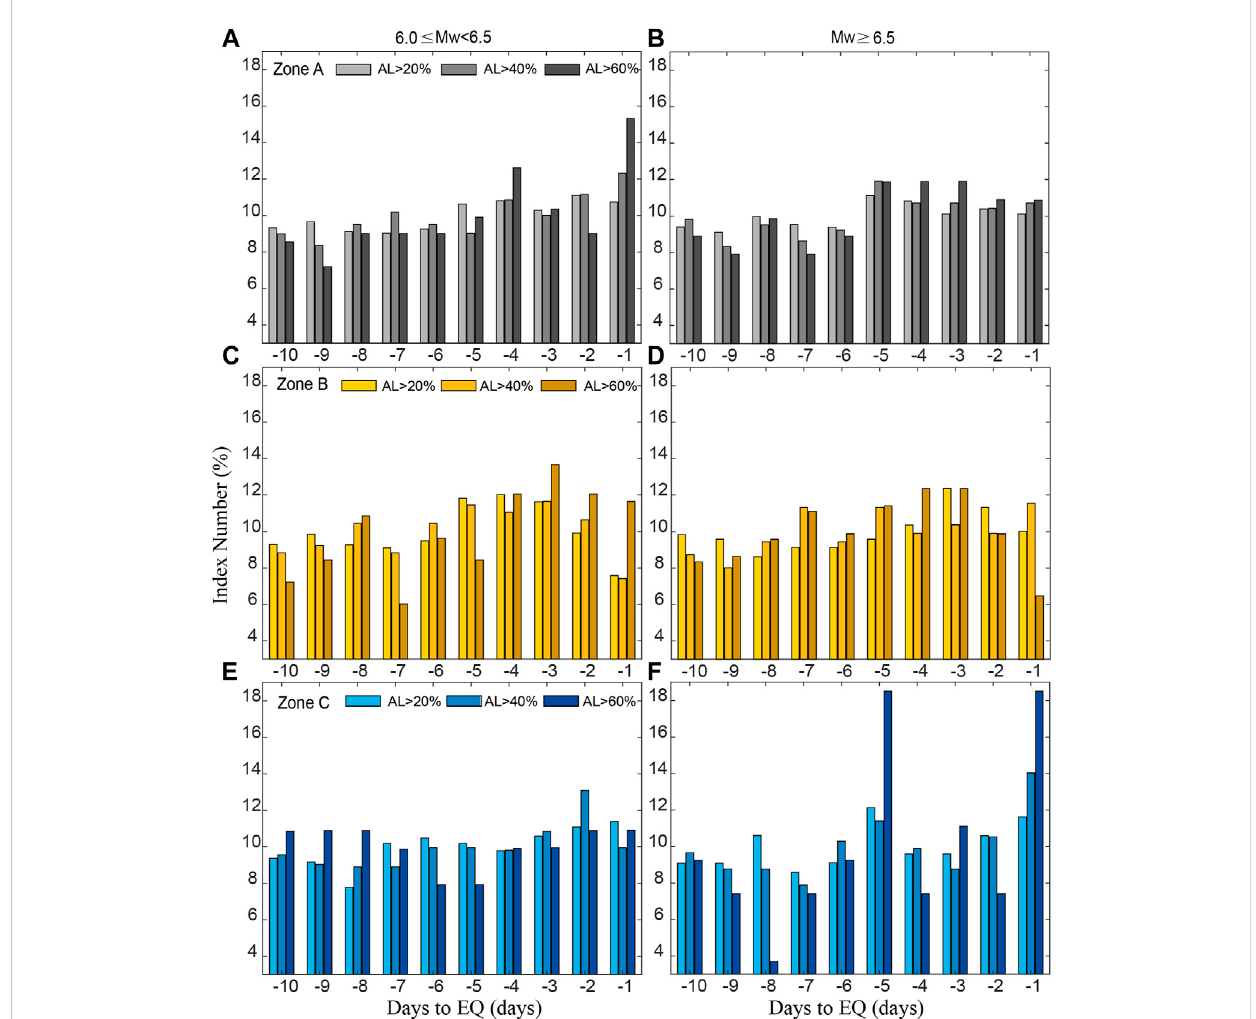
FIGURE 4 The Index Numbers of the seismo-ionospheric anomalies within 1-10 days before the global earthquakes during 2000-2020 (15-day sliding window). (A,C,E) aretheresultsof6.0 ≤ Mw < 6.5inZoneA,ZoneBandZoneC,respectively. (B,D,F) aretheresultsofMw ≥ 6.5inZoneA,ZoneBandZone C,